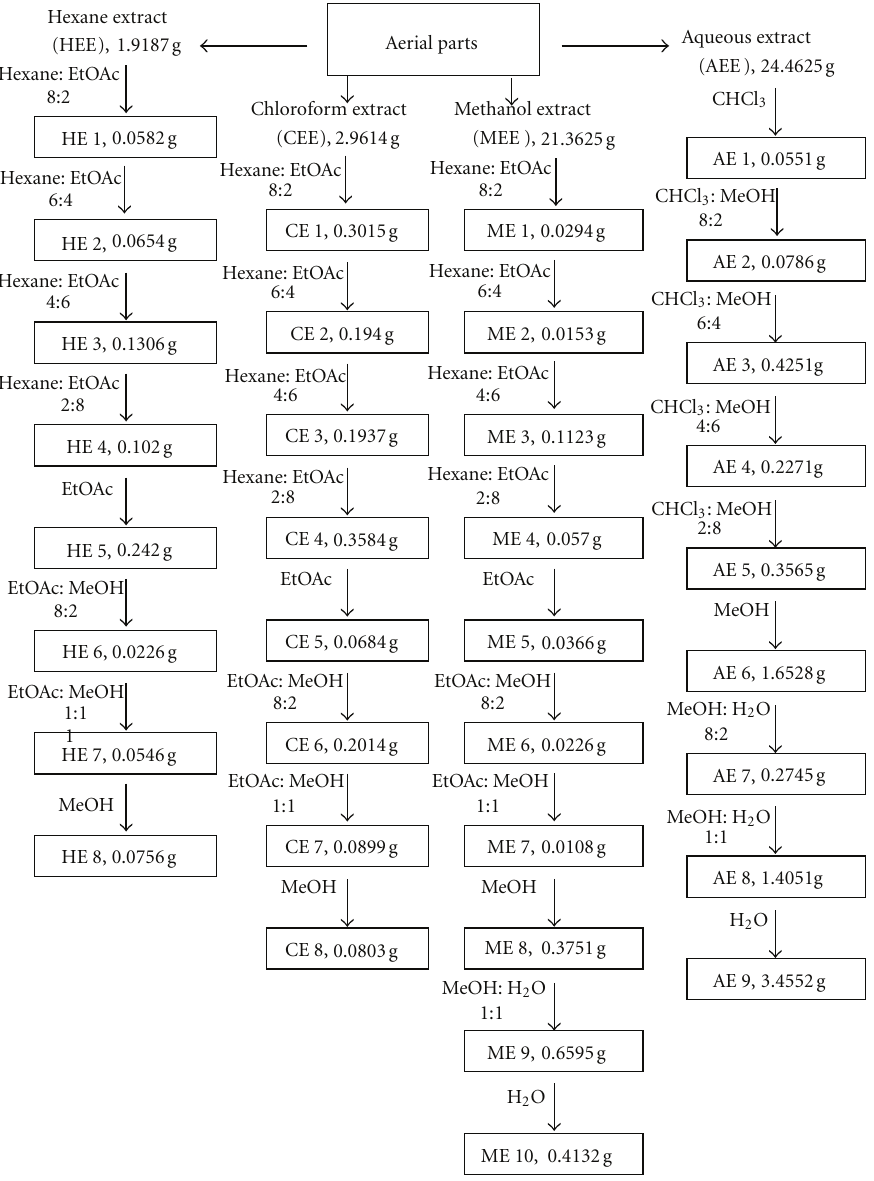
Figure 1: Diagram showing the fractionation of the hexane, chloroform, methanol, and aqueous extracts extracted from the aerial parts of Laennecia confusa . Ratios of the combined solvents are expressed in